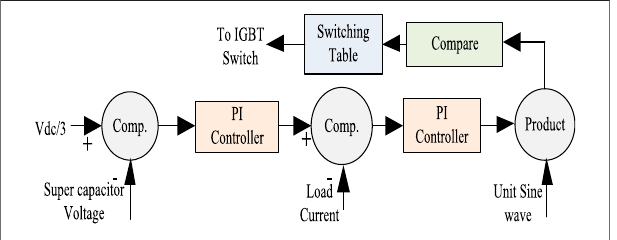
FIGURE 9 | DC link voltage balancing by PI-based